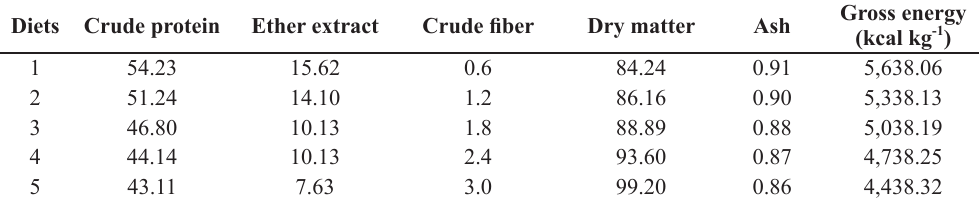
Composition of diets (% in dry matter) used during the feed training of Hoplias lacerdae